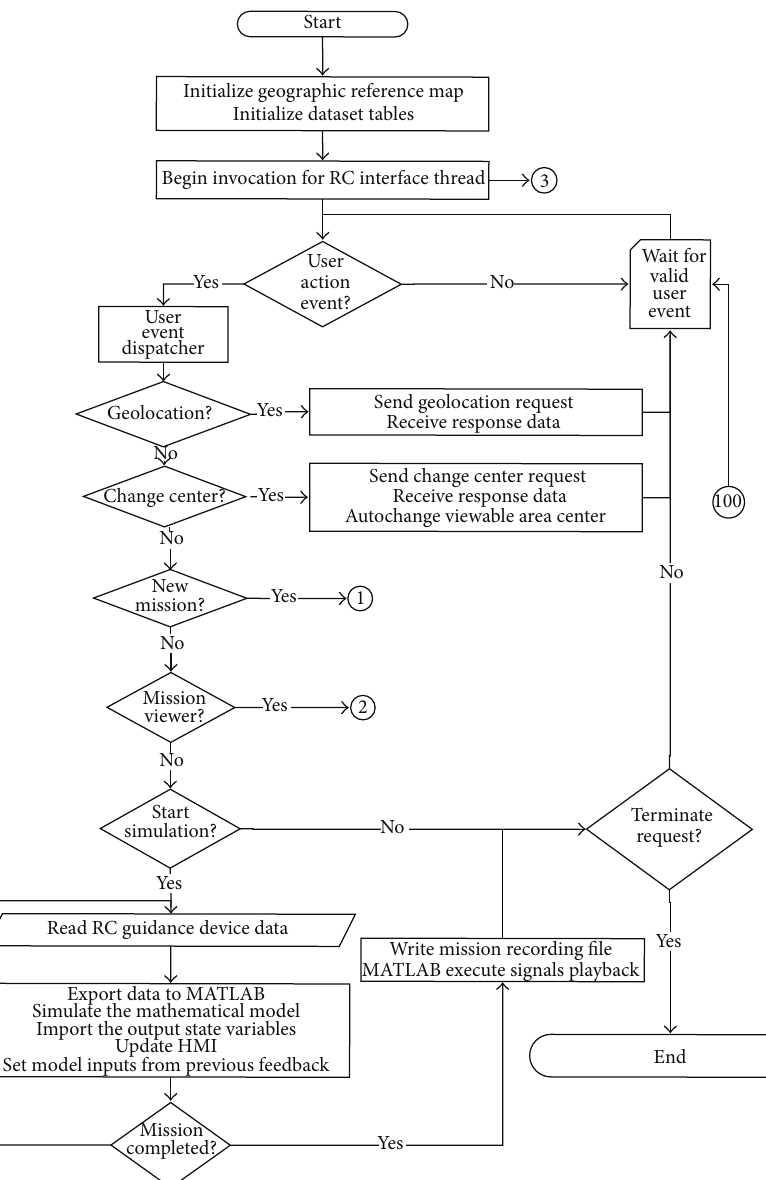
Figure 8: Proposed hybrid simulator complete